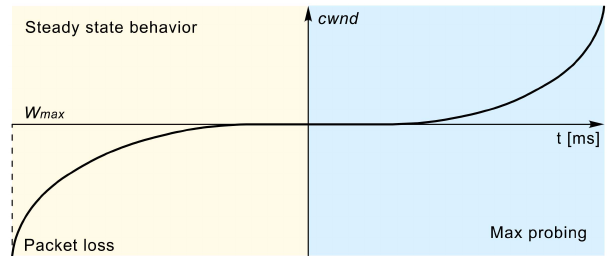
Figure 5. TCP CUBIC window growth function after the packet loss event.